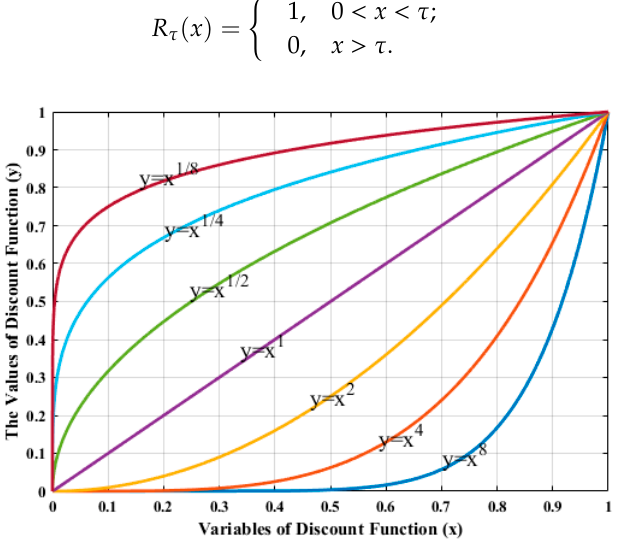
Figure 2. Power function with different exponents.